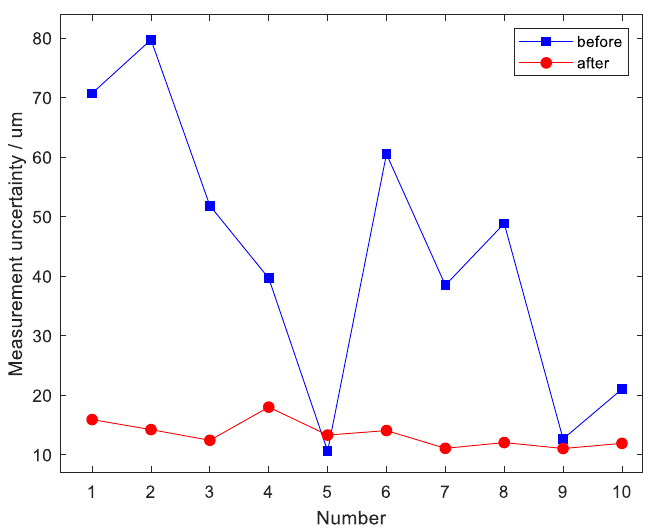
Figure 8. Uncertainty of the selected measurement point before and after optimization.